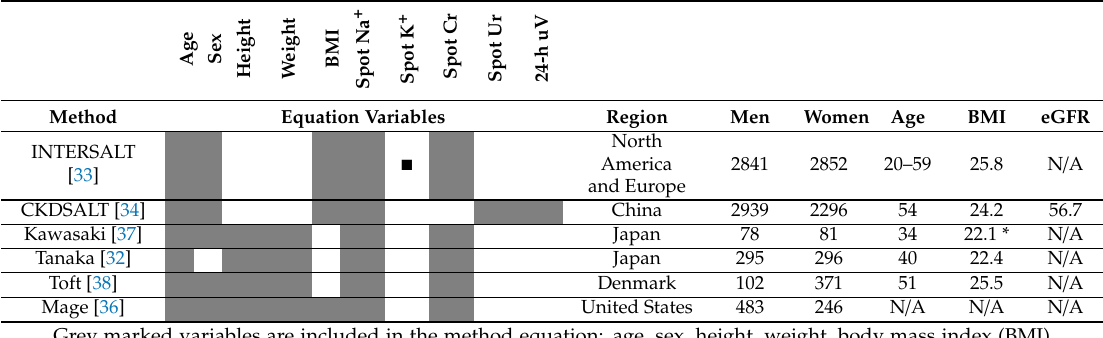
Grey marked variables are included in the method equation: age, sex, height, weight, body mass index (BMI), spot urine sodium concentration (spot Na + ), spot urine potassium concentration (spot K + ), spot urine creatinine concentration (spot Cr), spot urine urea concentration (spot Ur) and 24-h urine volume (24-h uV); (cid:4) indicates that the use of spot K + for estimation of sodium intake is optional. Summary of original study population characteristics